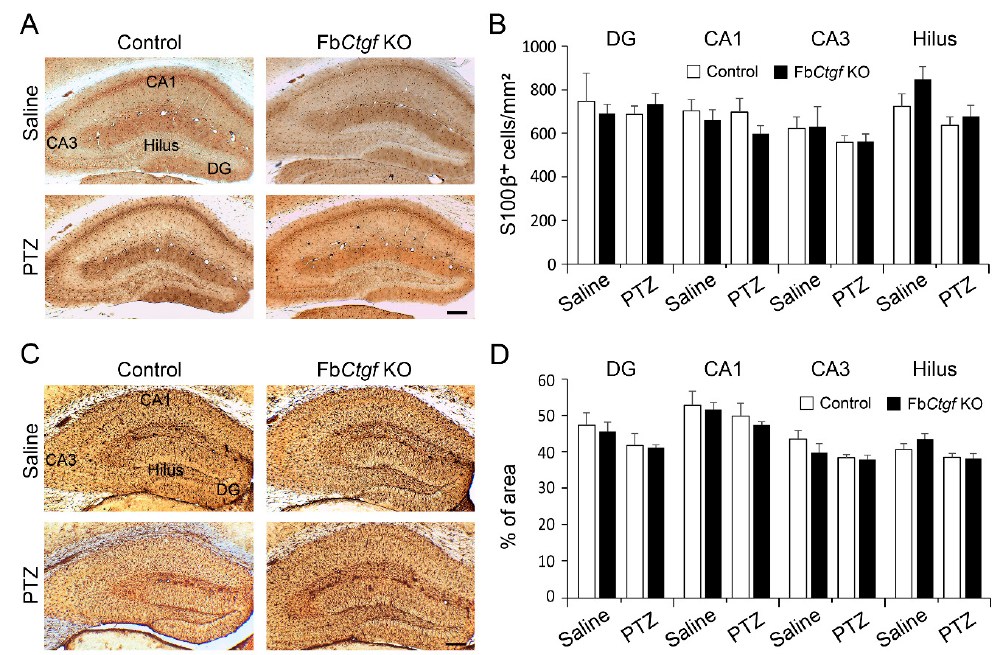
Figure 8. Status of astrocytes in the hippocampus. The density of S100 β -positive astrocytes ( A ) and the area of glial fibrillary acidic protein (GFAP)-positive signals ( C ) in the hippocampus of saline- and PTZ (50 mg / kg)-treated mice were measured ( B , D ). For saline group, n = 3 per genotype; for PTZ group, n = 5 per genotype. Results are mean ± SEM. Bar = 200 µ m.